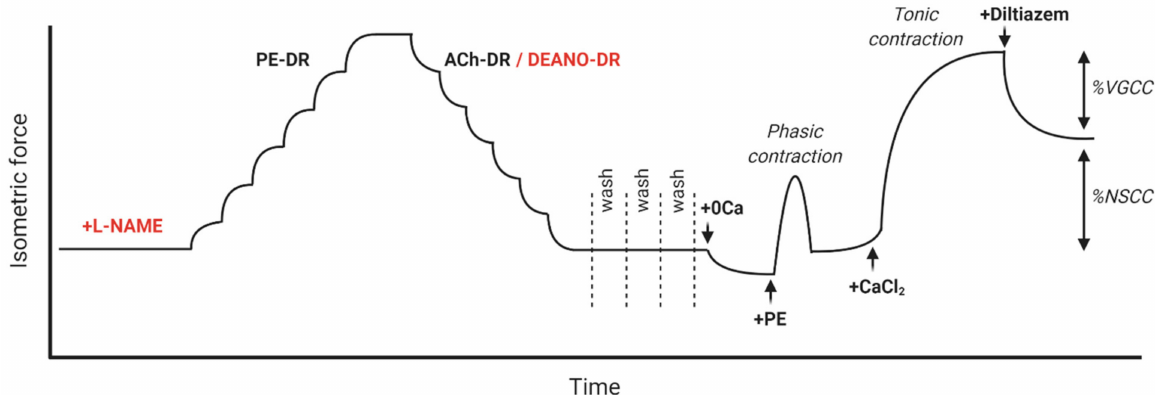
Figure A1. Isometric organ bath protocol overview to assess aortic reactivity. After dissecting the aortic segments, they were immediately immersed in Krebs solution and precontracted to 20 mN. All segments were left to equilibrate for 1 h prior to starting the protocol. The experiment in which L-NAME was added to organ bath was performed in parallel. A dose response (DR) to different doses of PE was performed to assess maximal contraction and sensitivity against α 1-adrenergic stimulation. Subsequently, endothelial dependent relaxation was induced by adding different doses of ACh in the absence of L-NAME. With L-NAME added to the organ bath, direct VSMC dependent relaxation was assessed after the addition of different doses DEANO. To get rid of any remaining active substance, the Krebs solution in the organ bath was washed away three times. Next, extracellular calcium was removed by adding calcium depleted Krebs solution (0Ca KR) to the aortic rings. A relatively small phasic contraction, depleting stored calcium, was elicited after the addition of PE to the organ bath. Subsequently, extracellular calcium was restored after the addition of calcium dichloride (CaCl 2 ), which results in a much larger tonic contraction. Finally, this tonic contraction was partly inhibited by adding the voltage-gated calcium channel blocker, diltiazem. Concentrations of the used vasoactive substances are included in the Materials and Methods